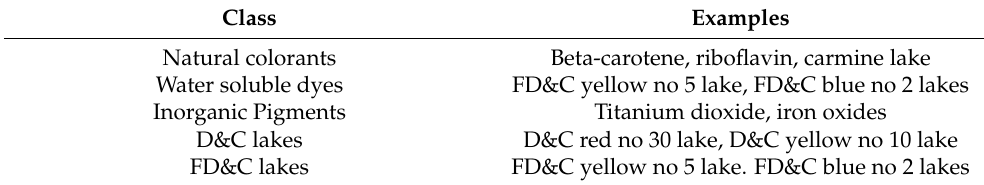
Table 6. Opacifiers and colorants are used in FC